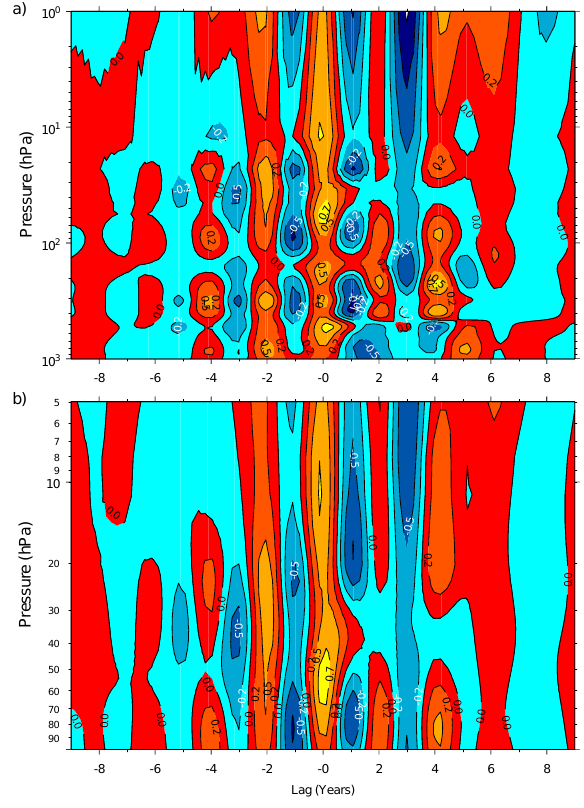
Fig. 3. Top panel (a) shows the time-lagged cross-covariance be- tween the summer mesospheric temperatures and each level of the winter stratospheric temperatures between 1000 and 1hPa. Neg- ative lags correspond to the mesospheric temperatures leading the stratospheric temperatures. The lower panel (b) shows the same data but restricted to approximately the same altitude range over which QBO data are available, 100 to 5hPa. Blue denotes negative (anti-correlation) and red denotes positive